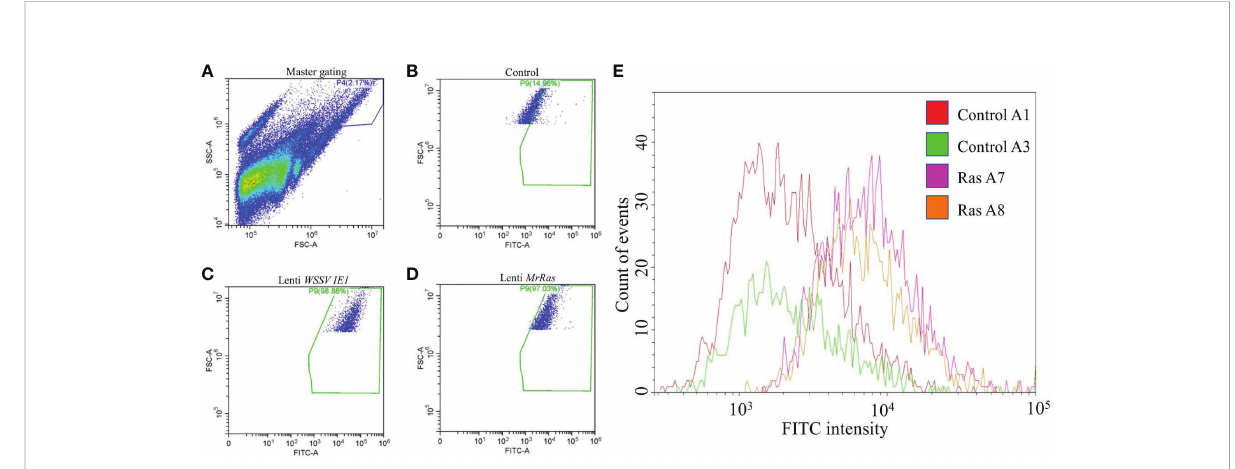
FIGURE 7 Depiction of a sub-population of cells exhibiting a higher rate of transduction. (A) The primary scatter plot shows entire events analyzed in control cells, gating on a speci fi c population based on granularity and larger cell size. (B) FITC signal of the control cells expressed innate auto fl uorescence. (C) FITC signal of the positive control plasmid lenti WSSV IE1 transduced cells. (D) FITC signal of the mutated lenti MrRas transduced cells. (E) The traces for the positively transduced cells for FITC (purple and orange traces) were overlaid over the traces for the control (red and